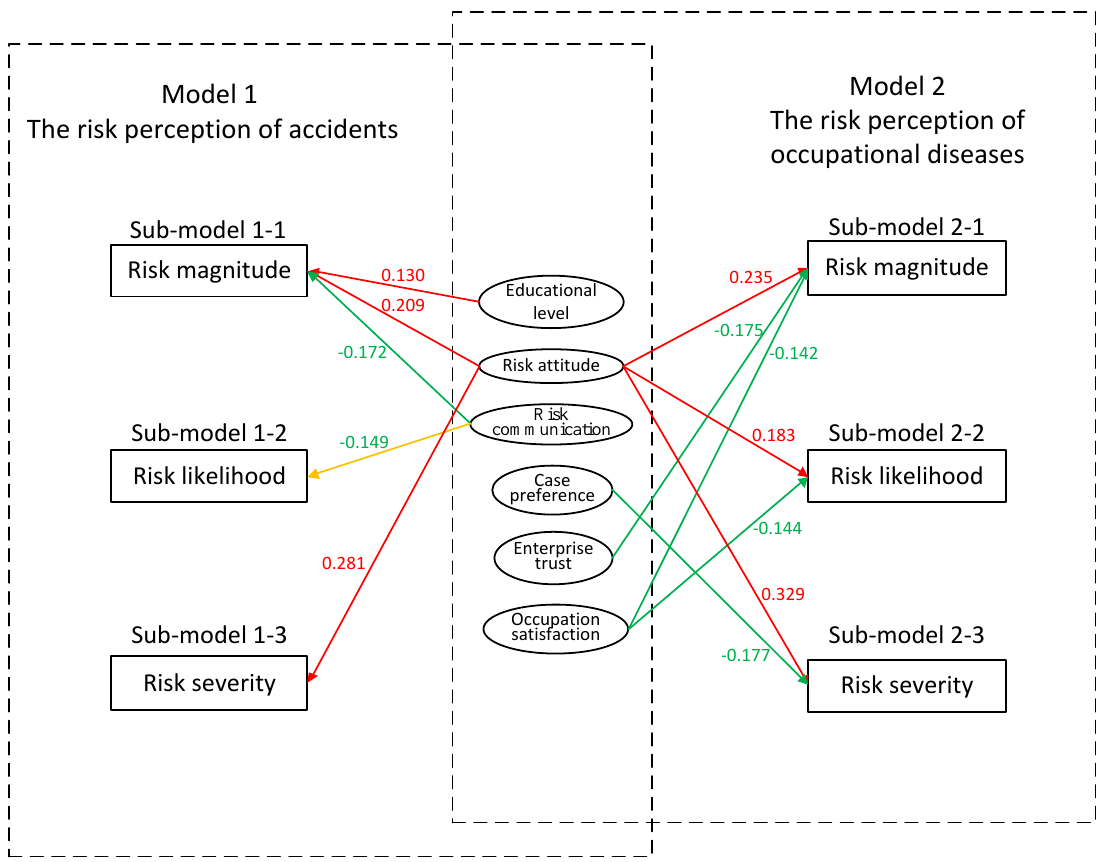
Note: The red lines indicate that the regression coefficients are positive, the green lines are negative, and the orange line indicates that the path cannot be used for prediction, but only for interpretation. Figure 2. The modified influencing factor model. Figure 2. The modified influencing factor